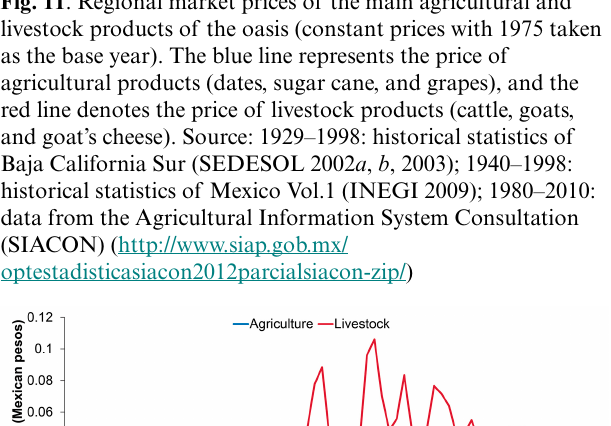
Fig. 11 . Regional market prices of the main agricultural and livestock products of the oasis (constant prices with 1975 taken as the base year). The blue line represents the price of red line denotes the price of livestock products (cattle,